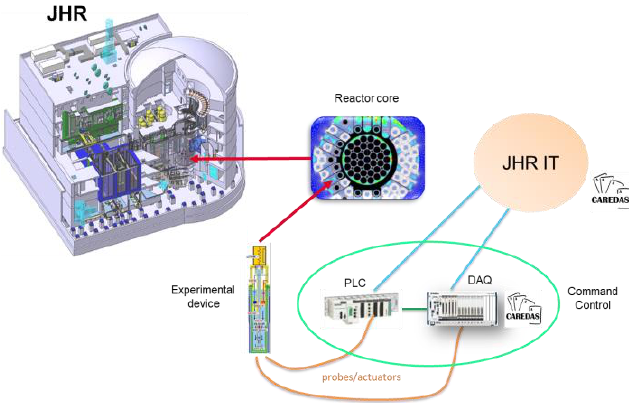
Fig. 1. Control command of JHR experimental